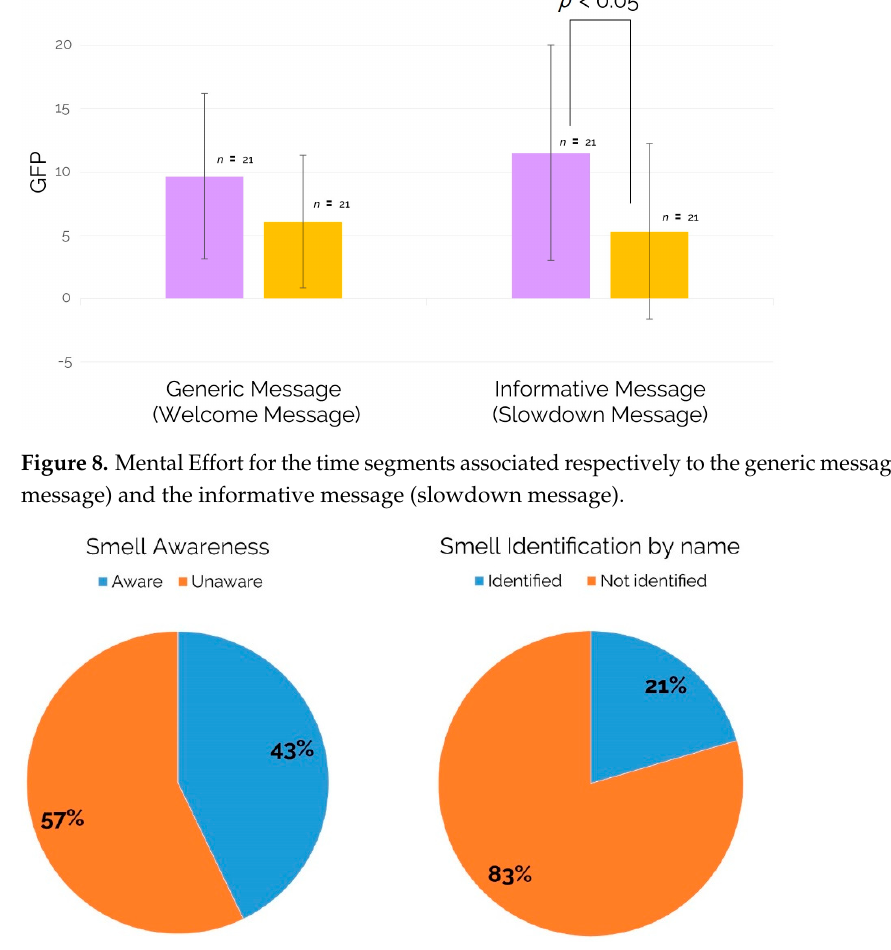
Figure 9. Self-reported measure of “smell awareness” and “smell identification by name”, provided by subjects at the end of the experimental session.